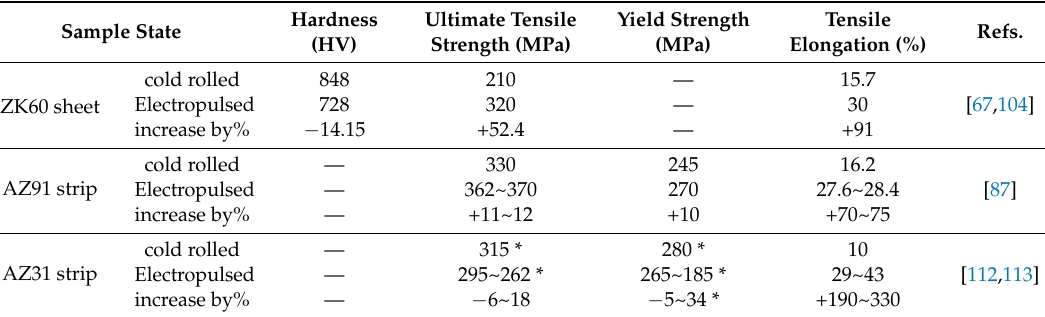
Table 3. Mechanical properties of magnesium alloys before and after